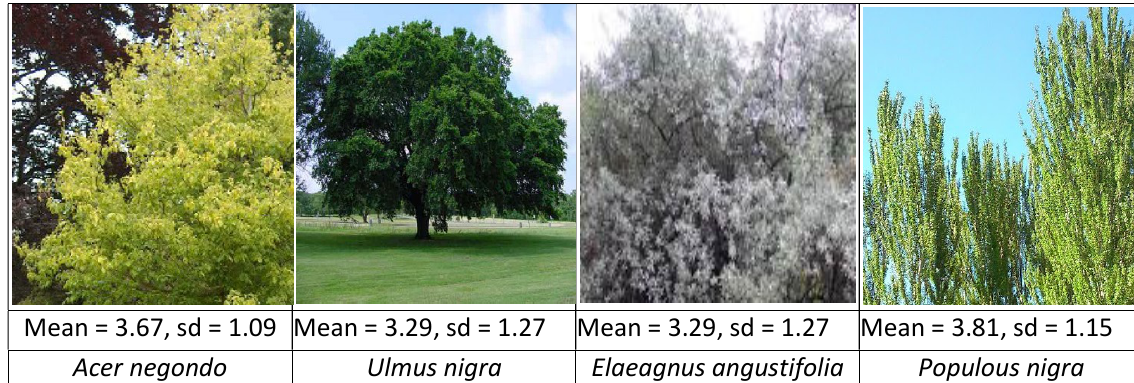
Figure 3a: Public Perceptions for Trees in Urban Park in